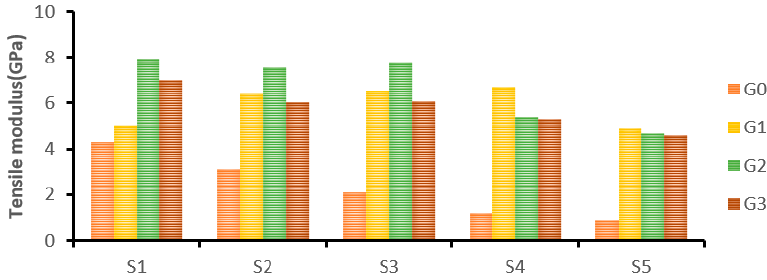
Figure 6. The e ff ect of GNP on the tensile modulus of laminated Figure 6. The effect of GNP on the tensile modulus of laminated composites.